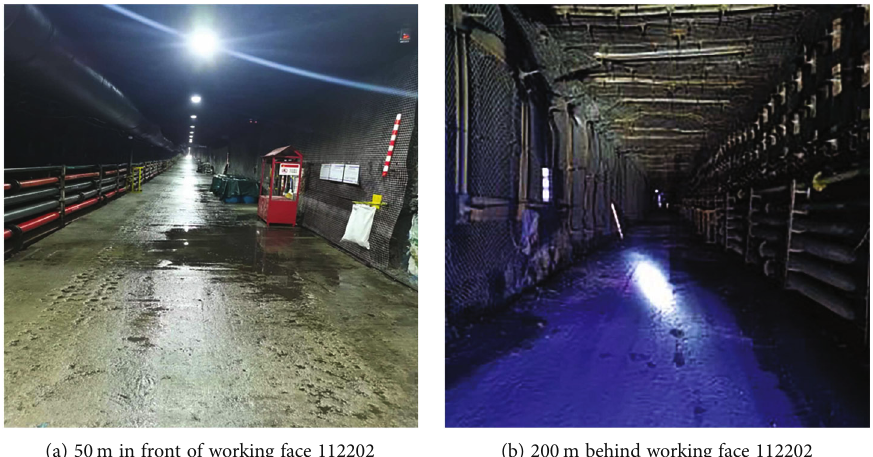
Figure 15: Control e ff ect of hydraulic fracturing of the surrounding rock of auxiliary transport roadway